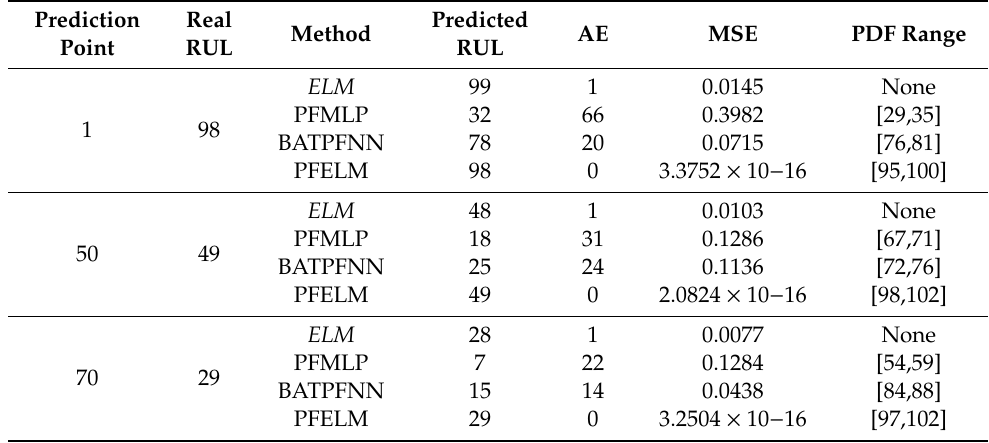
Figure 27. Capacity prediction error from the 70th cycle. Table 5. Comparison of Prognosis Results of B0018.